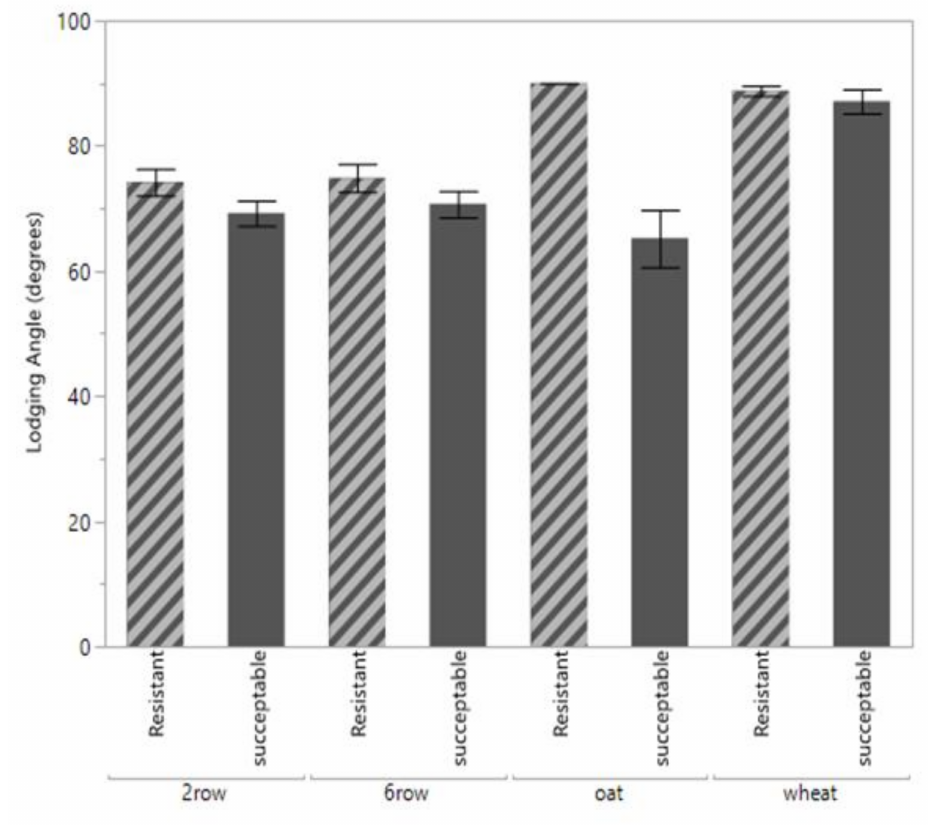
Figure 6. Comparison of means for lodging angles of pooled resistant and susceptible lines of all small cereal grains, where the angle of 90 degrees is upright and 0 degrees is perpendicular to the ground. N =